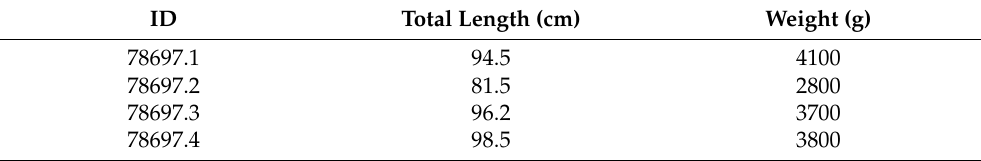
Table 1. Identification code (ID), total length (cm) and weigh (g) of the four sturgeons. ID Total Length